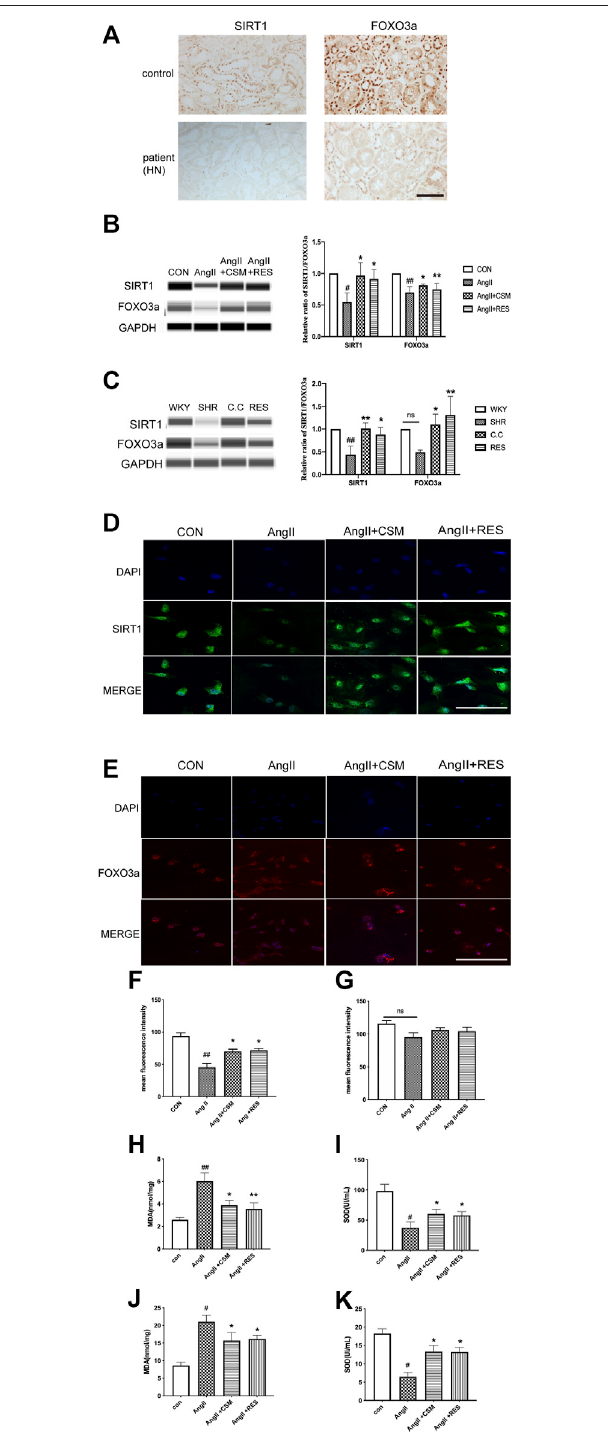
FIGURE 5 | Experimental validation of the SIRT1/FOXO3a/ROS signalingpathways invivo and invitro . (A) DownregulatedSIRT1andFOXO3a existed in HN patients (bar = 40 μ m). (B) Capillary electrophoresis immunoquanti fi cation of SIRT1 and FOXO3a on NRK-52E cells in each group. (C) CapillaryelectrophoreticanalysisofSIRT1andFOXO3aexpression in the rat renal cortex of various study groups. (D , E) CMS regulated SIRT1